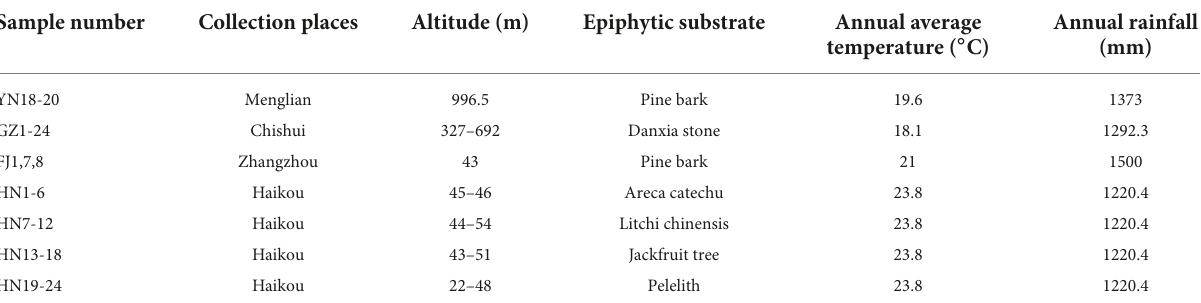
FIGURE1 The geographical distribution map.